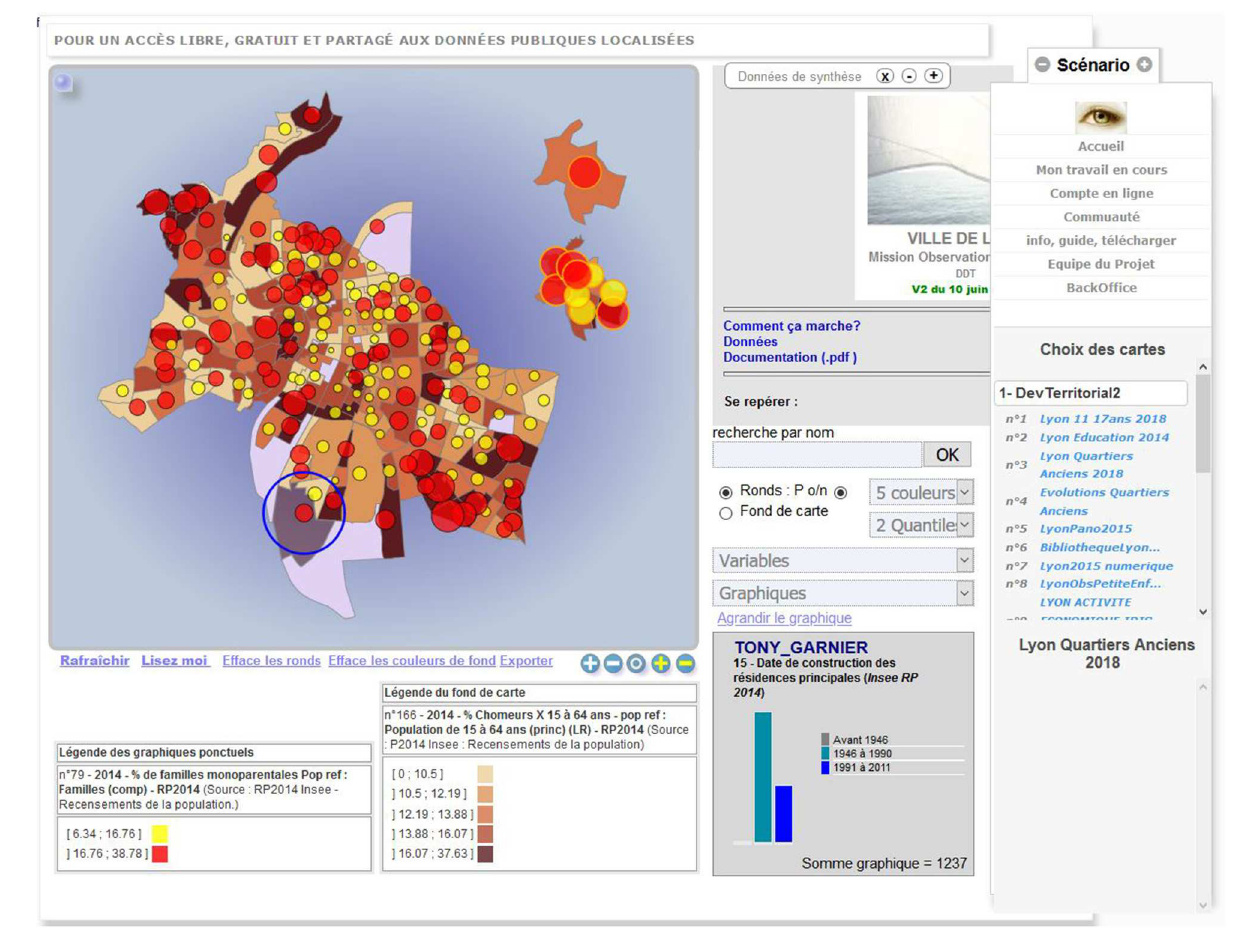
FIGURE 3 | Screenshot of the VLKO cartography tool depicting a map of unemployment rates (area) and single-parent households